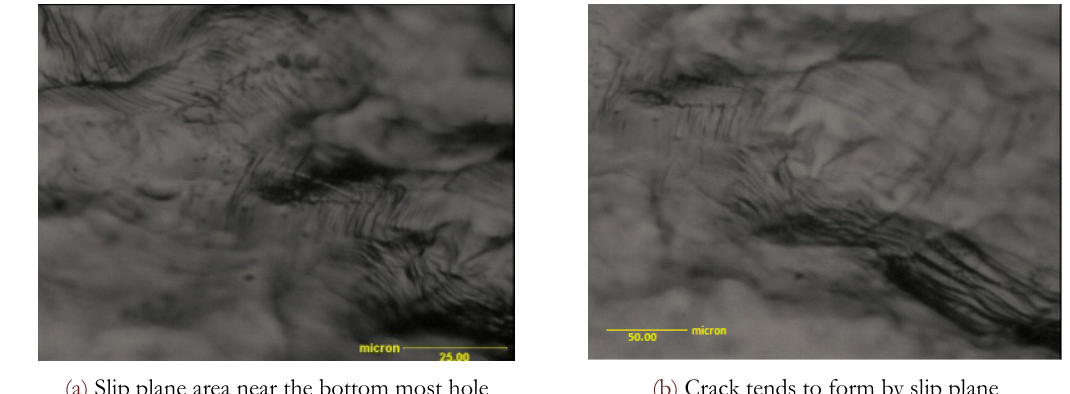
Figure 18: Slipping Phenomena in the specimen with 0.5 mm